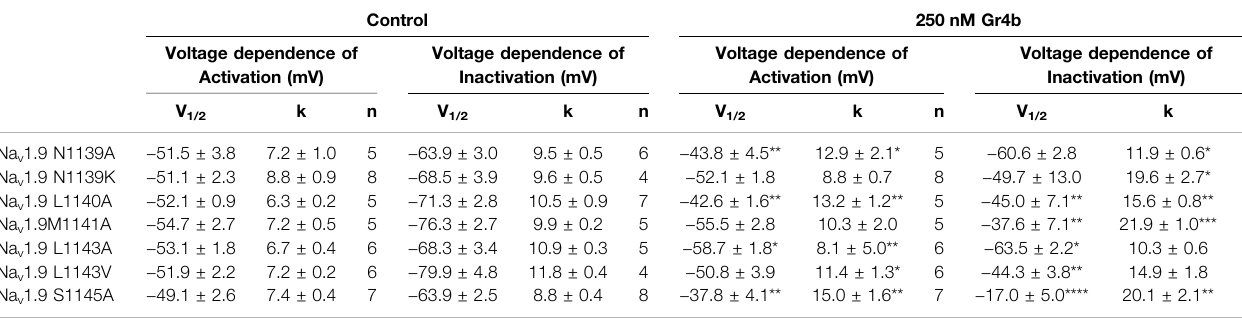
TABLE 4 | The effects of 250 nM Gr4b on activation of Na v 1.9 mutants. Control 250 nM Gr4b Voltage dependence of Voltage dependence of Activation (mV) Inactivation (mV)